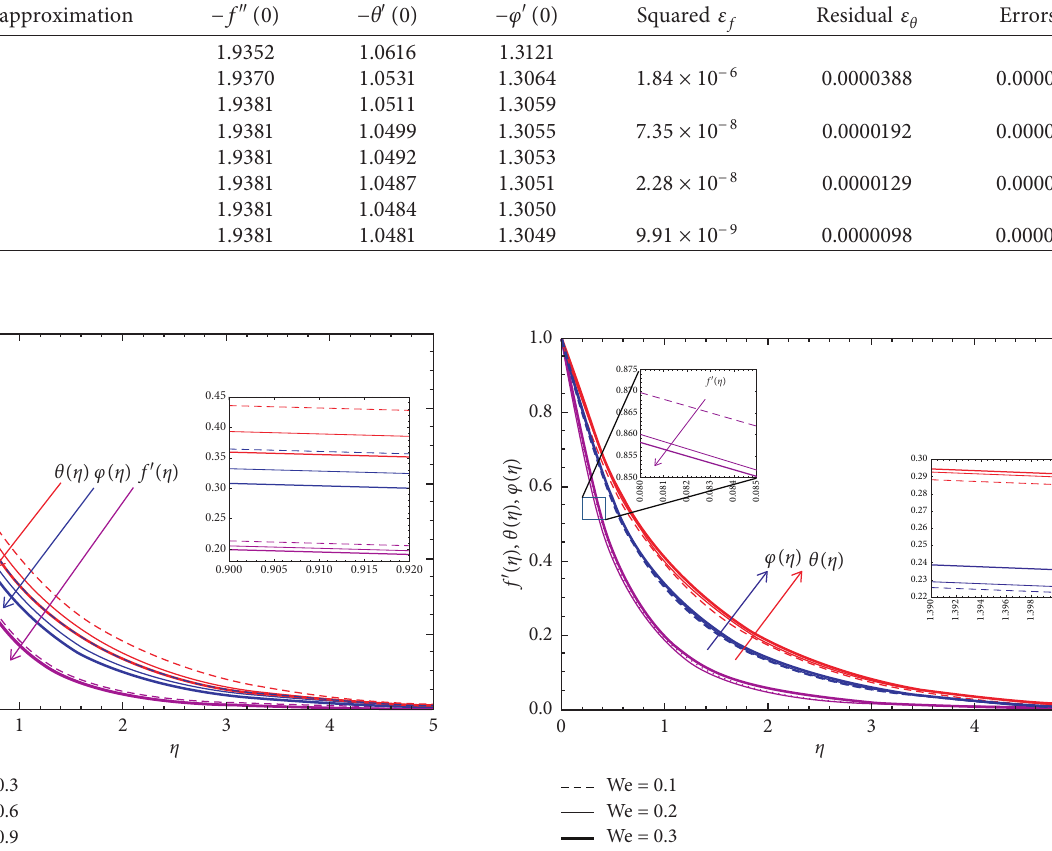
Figure 5: Effects of Weissenberg number We on velocity, tem- perature, and concentration profiles.